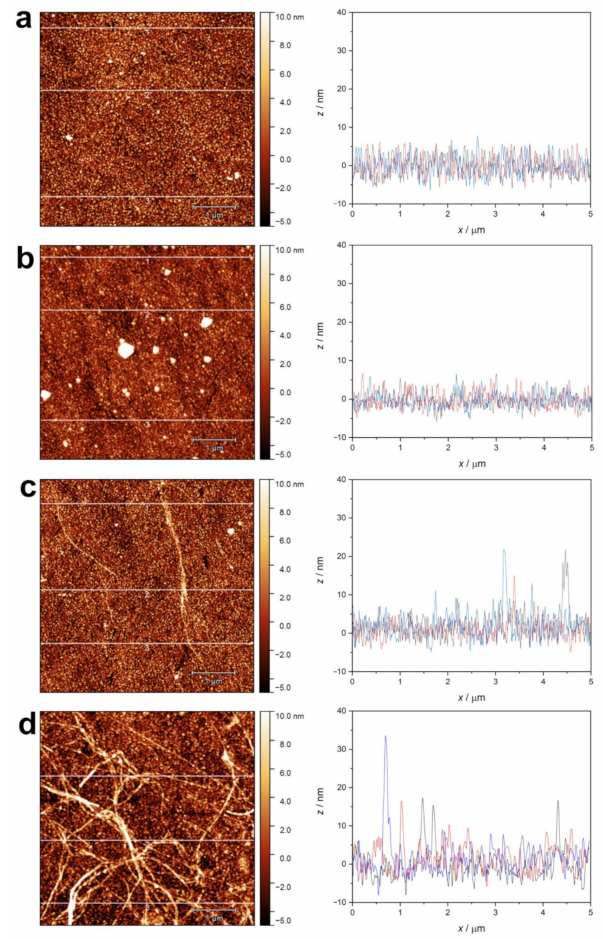
Figure 11. AFM topographic images of QCM sensor crystal surfaces after protein adsorption mea- surement. ( a ) native lysozyme at pH 2.0; ( b ) native lysozyme at pH 7.0; ( c ) lysozyme amyloid at pH 2.0; ( d ) lysozyme amyloid at pH 7.0. Line profiles at three selected positions (1 (black), 2 (red), 3 (blue)) are